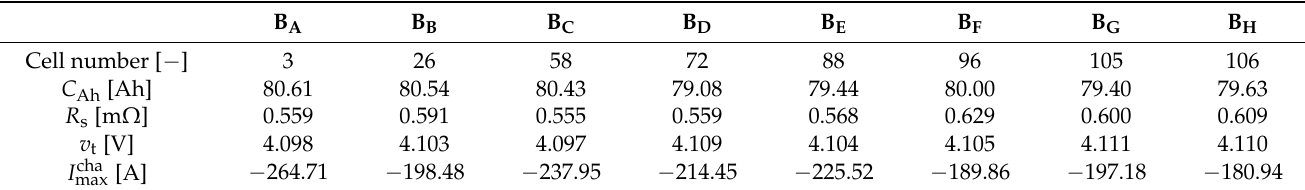
Table 1. Cell parameters of B A –B H